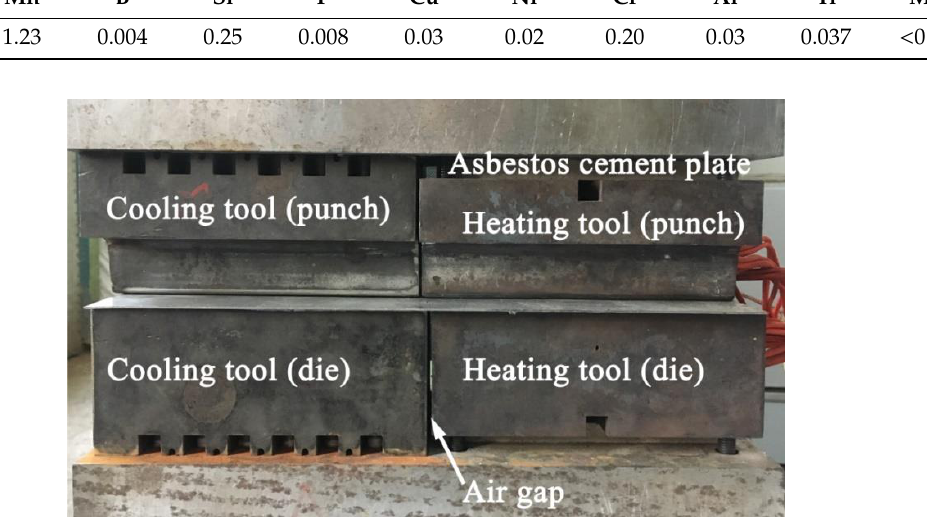
Figure 1. Schematic of the experimental apparatus.